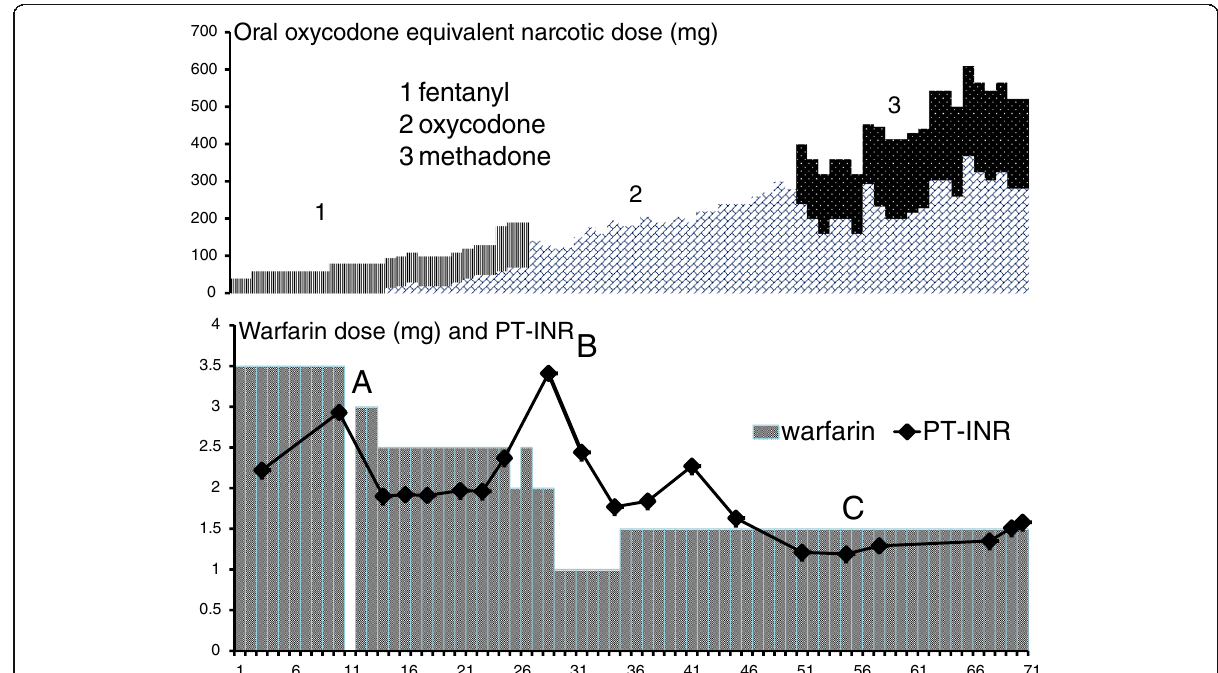
Fig. 1 Transition of oral oxycodone equivalent narcotic dose, warfarin dose, and PT-INR. Horizontal axis : number of days elapsed since hospitalization (days). Figure top : transition of oral oxycodone equivalent narcotic dose. Vertical axis : oral oxycodone equivalent narcotic dose (mg). Figure bottom : transition of warfarin dose and PT-INR. Vertical axis : warfarin dose (mg) and PT-INR. a The peak of PT-INR after administration of acetaminophen. b The peak of PT-INR after administration of oxycodone. c The plateau of PT-INR after administration of methadone. Methadone was not converted to form a ratio with other opioids; the graph was prepared by converting methadone 15 mg to oral oxycodone 80 mg